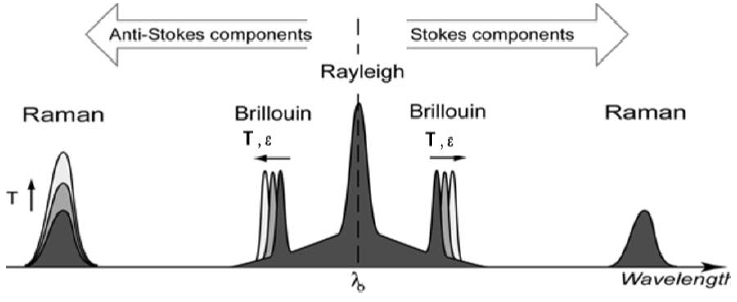
Figure 5. Typical spectrum of spontaneous light scattering in a